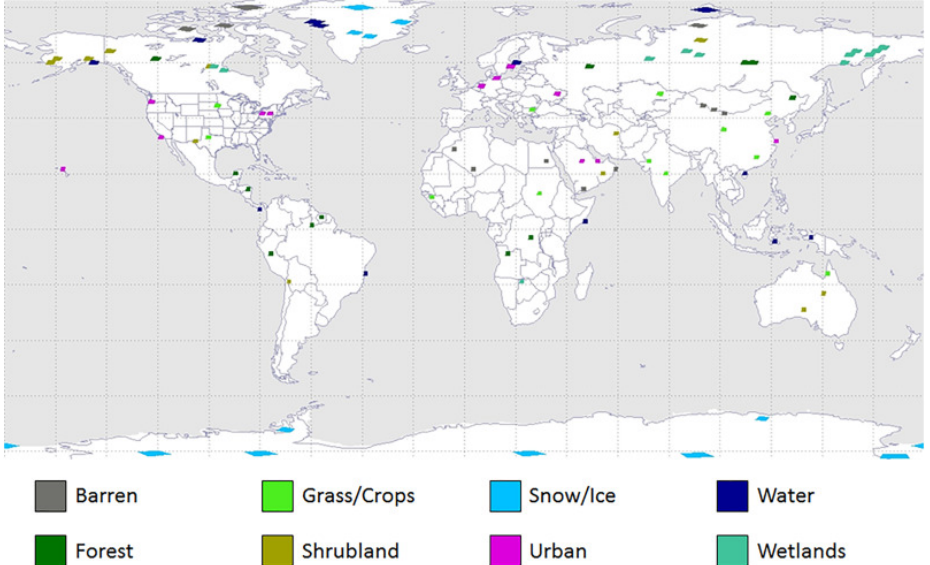
Figure 1. Global distribution of the 96 unique Landsat 8 Cloud Cover Assessment scenes, adopted from